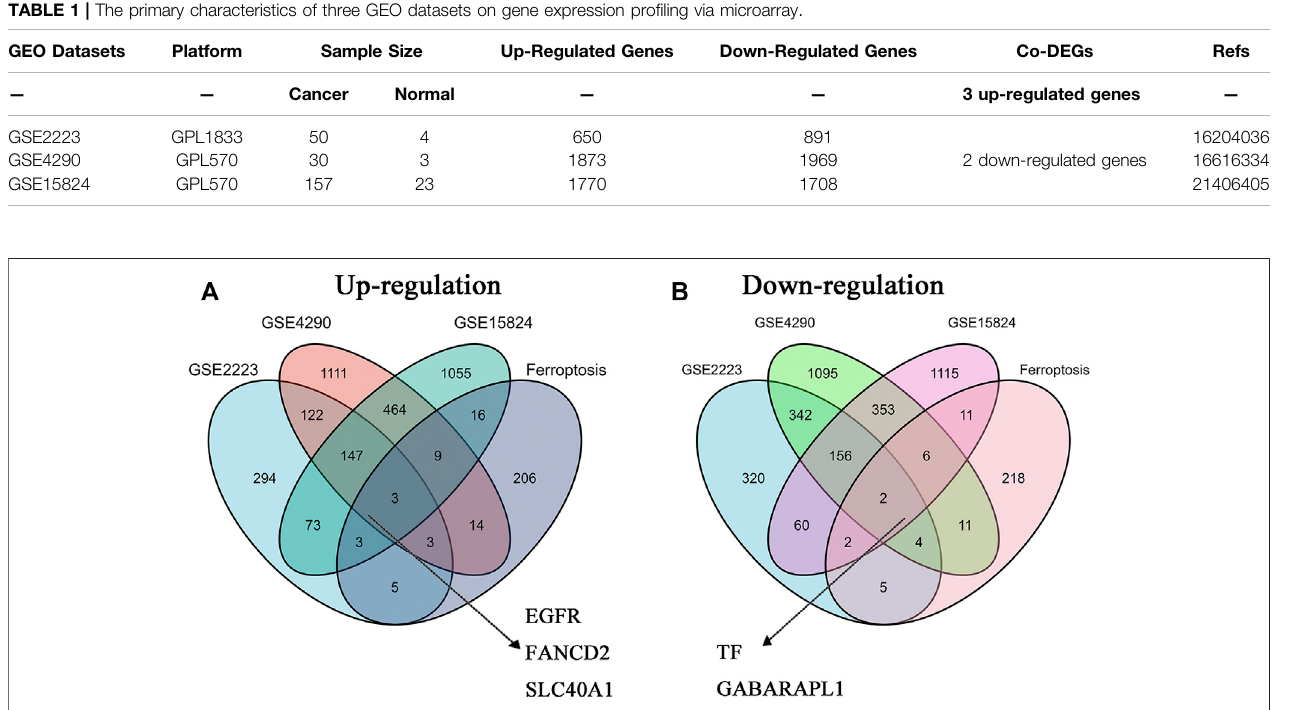
Frontiers in Pharmacology |